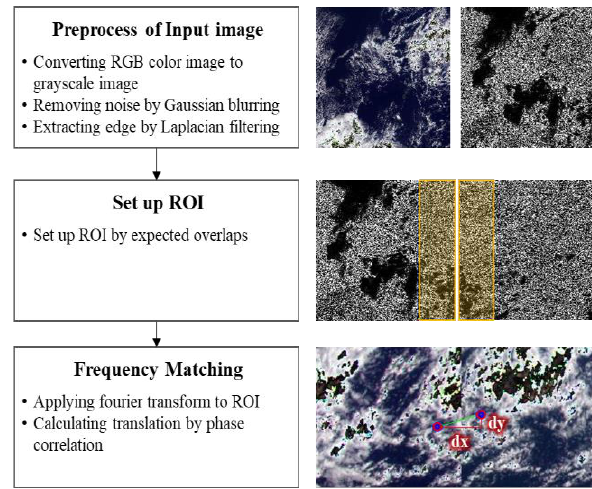
Figure 2. Process of the used frequency matching method